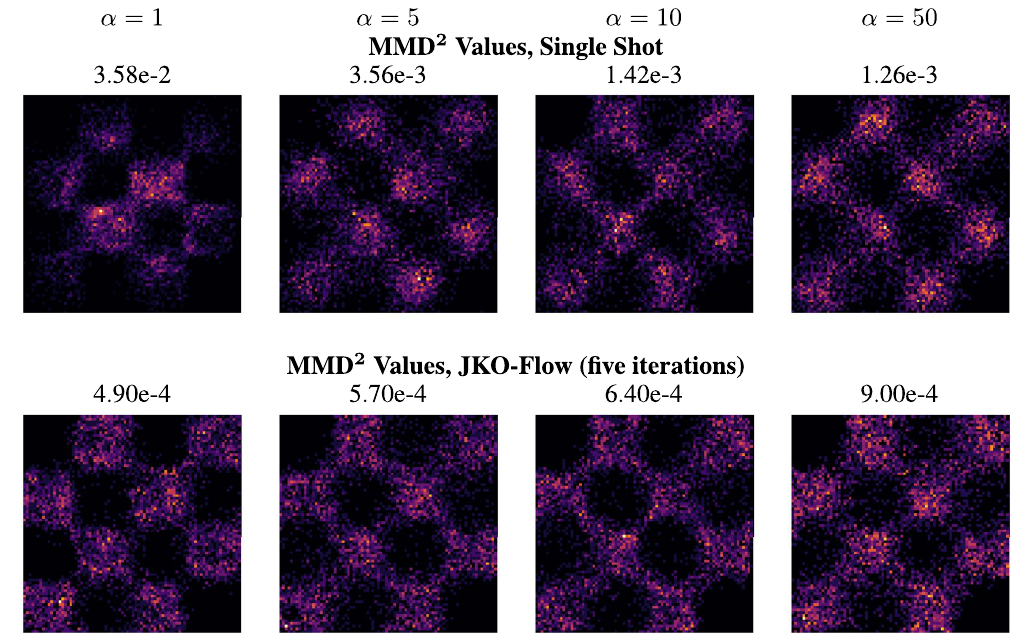
ρ 0 using the standard one-shot approach (top row). Figure 1. Checkerboard dataset: generated samples of Generated using our proposed JKO-Flow using five iterations (bottom row). Here, we use α = 1 , 5, 10, 50. JKO- (cid:31) Flow returns consistent results regardless of the value of α .